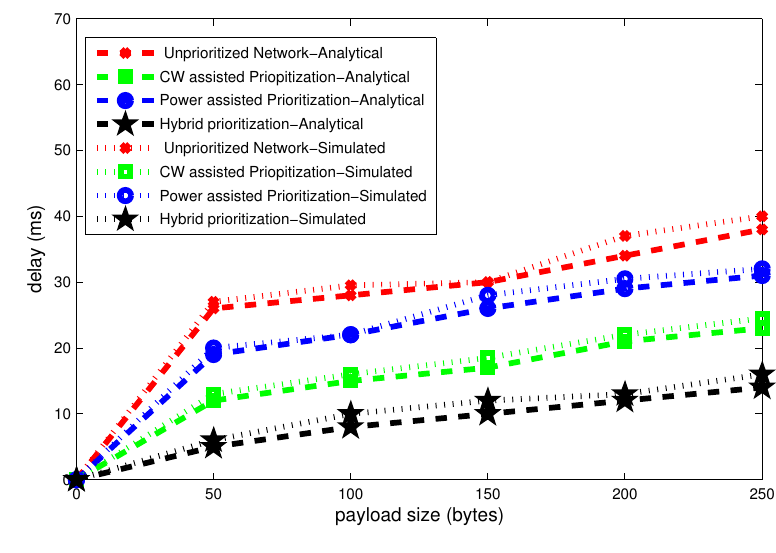
Figure 11. Effect of payload size on delay.